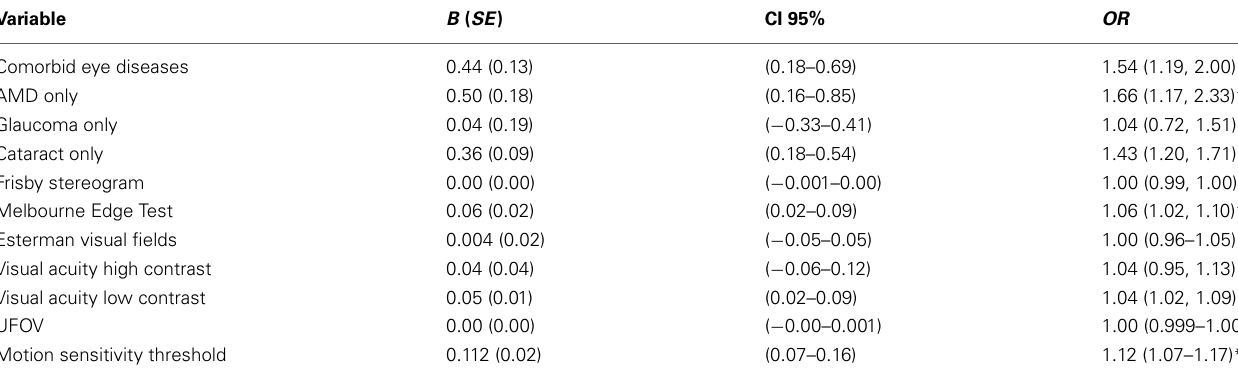
Table 4 | Association between eye disease and visual function and total GAD